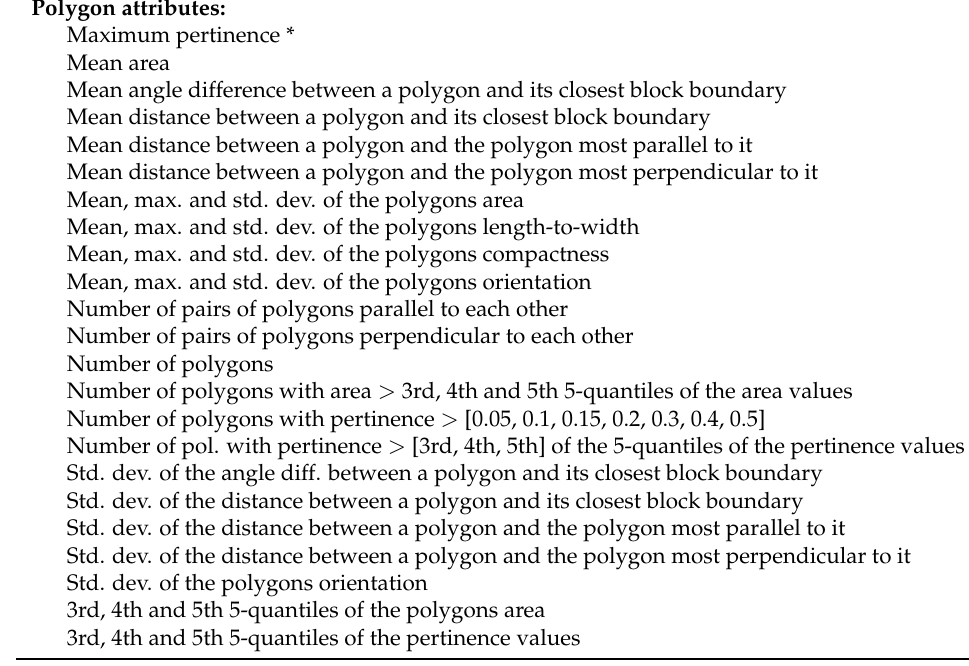
Figure 2. Outcome of the main steps involved in the computation of block attributes from extracted lines and polygons. ( a ) The input to the procedure is the intensity SAR image of each block. ( b ) Lines extracted from the input image. ( c ) Polygons extracted from the input image. ( d ) Lines and the block’s boundaries projected to the local coordinate system. ( e ) Polygons and the block’s boundaries projected to the local coordinate system. ( f ) Network created from the extracted polygons. Table 3. Attributes computed from the polygons extracted from the SAR intensity image of each block. The polygon extraction procedure is described in detail in Novack [49]. * The pertinence of the polygon to an ideal building polygon shape. The computation of this pertinence is demonstrated in Novack and Stilla